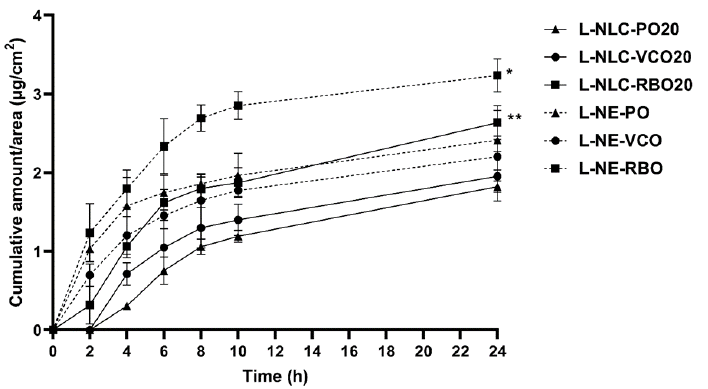
Figure 8. In vitro cumulative amount–time profiles of lutein that permeated through the epidermis from L-NLC and L-NE formulations. * Statistically significant difference comparing all L-NE formulations ( p < 0.05) and ** statistically significant difference comparing all L-NLC formulations ( p < 0.05).